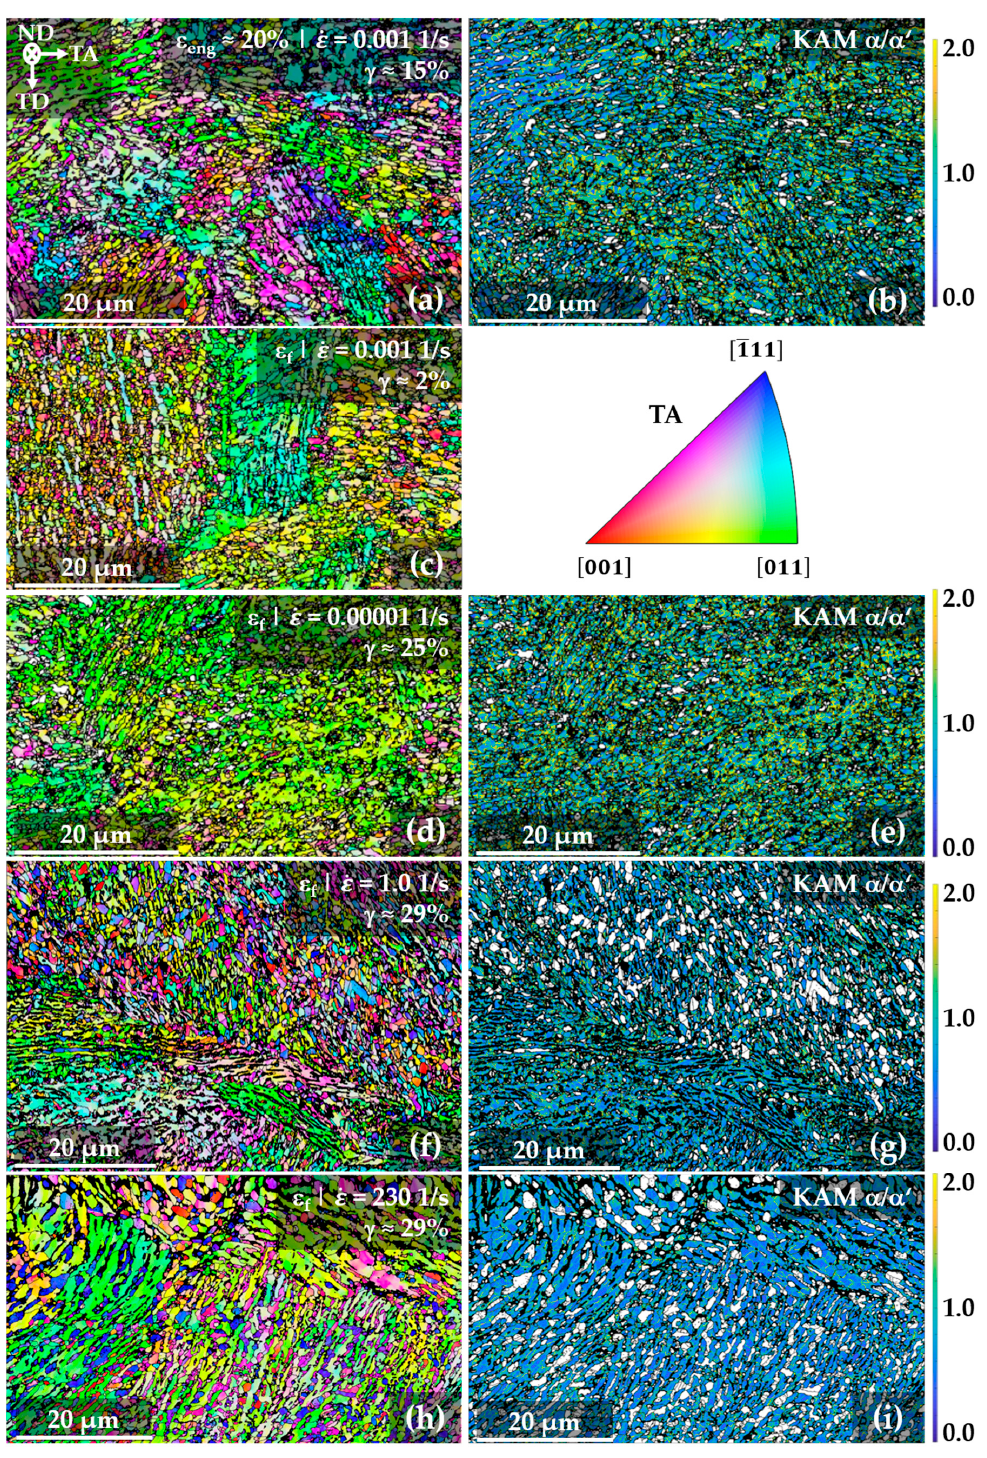
Figure 9. EBSD IPF maps for 0.001 1/s after ( a ) 20% ε eng and ( c ) ε f , as well as for the microstructure after straining until fracture at ( e ) 0.00001 1/s, ( g ) 1.0 1/s, and ( i ) 230 1/s. Corresponding EBSD maps with color coding according to KAM values of α and α ’ in ( b , f , h ) and ( j ) are shown. White areas in the KAM maps correspond to γ .